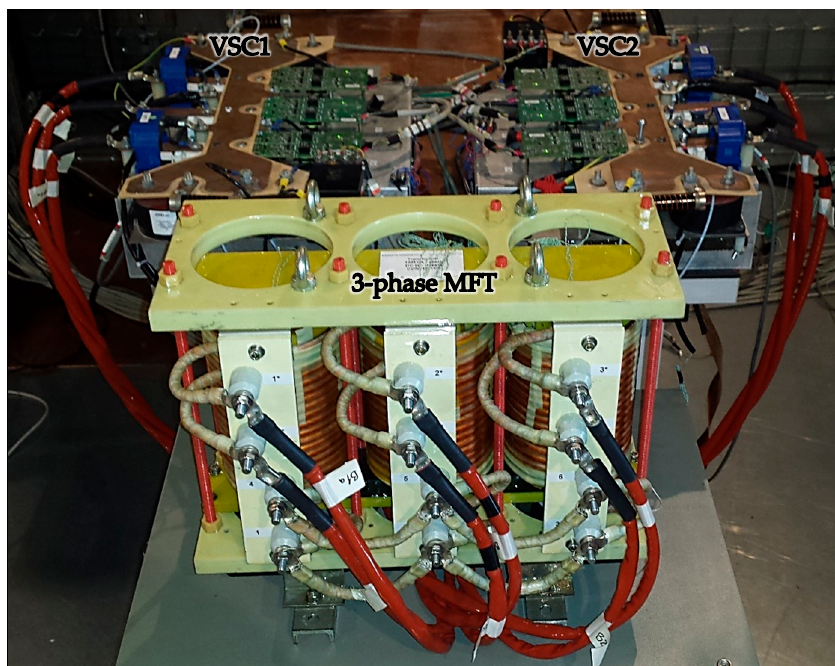
Figure 13. 100 kW three-phase isolated dc-dc converter test bench implementation.